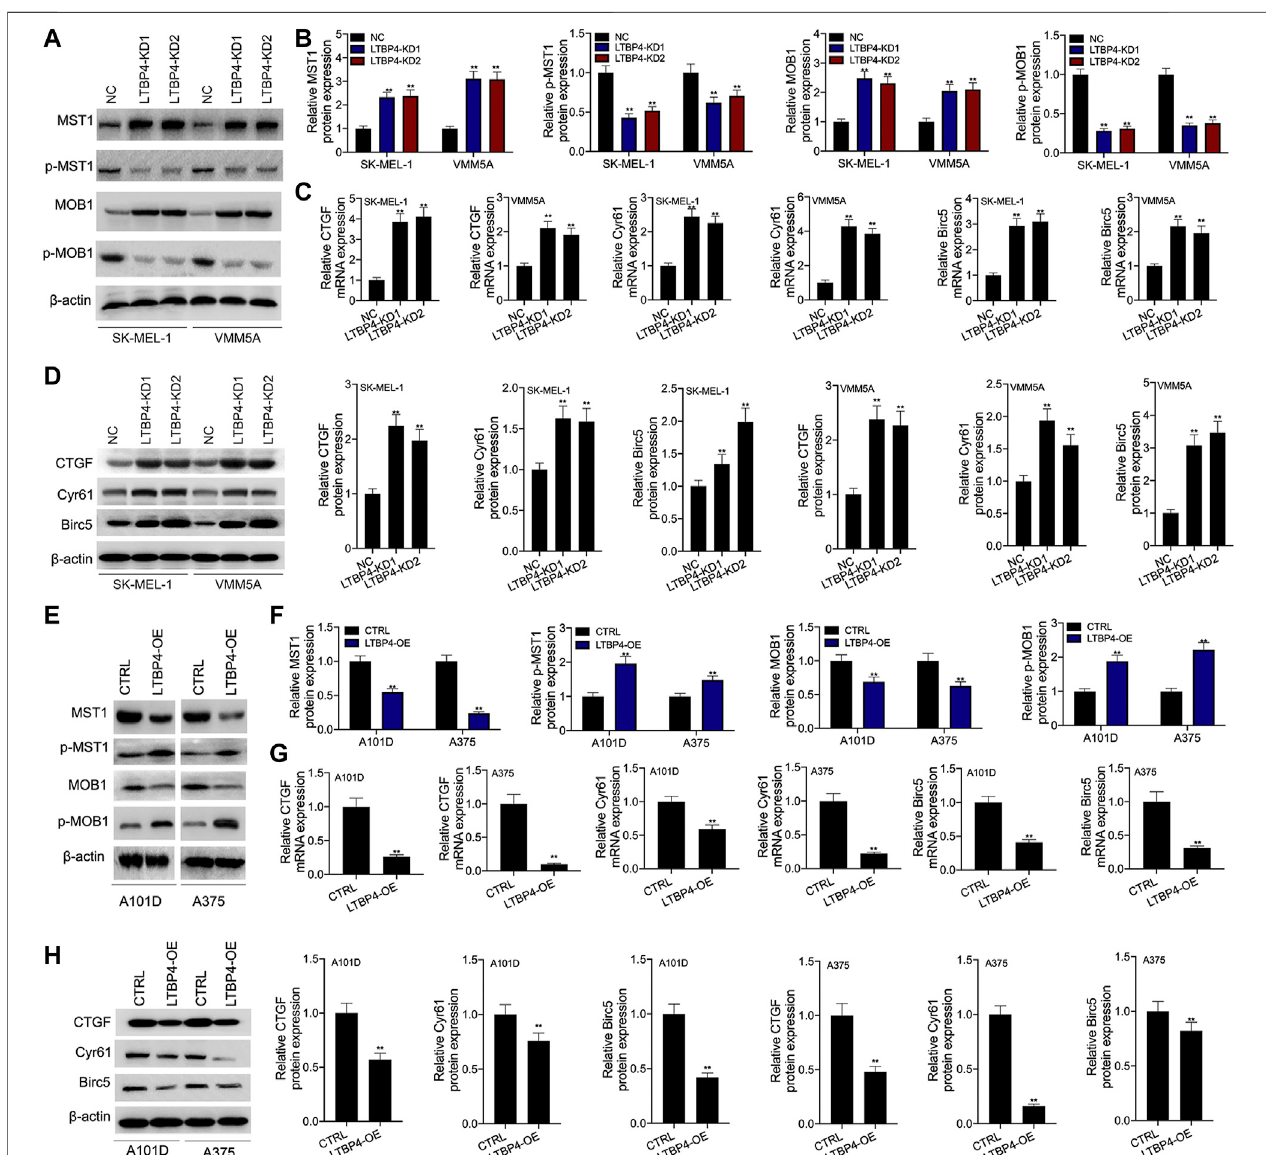
FIGURE 7 | LTBP4 inhibited the activation of Hippo signaling pathway in vitro . After shRNA-LTBP4#1 or #2 was transfected into SK-MEL-1 and VMM5A cells (A and B) theexpressionsofMST1andMOB1andthephosphorylationlevelofMST1andMOB1weredetectedbywesternblottingassay, (C) themRNAlevelsofCTGF, Cyr61, and Birc5 were detected by RT-PCR assay, (D) the protein levels of CTGF, Cyr61, and Birc5 were detected by western blotting assay. After LTBP4 expressing plasmids transfected A101 and A375 cells (E and F) the expressions of MST1 and MOB1 and the phosphorylation level of MST1 and MOB1 were detected by western blotting assay, (G) the mRNA levels of CTGF, Cyr61, and Birc5 were detected by RT-PCR assay, and (H) the protein levels of CTGF, Cyr61, and Birc5 were detected by western blotting assay. β -actin was used as a load control. Data are presented as the mean ± standard deviation. ** p < 0.01 vs CTRL/or NC group.